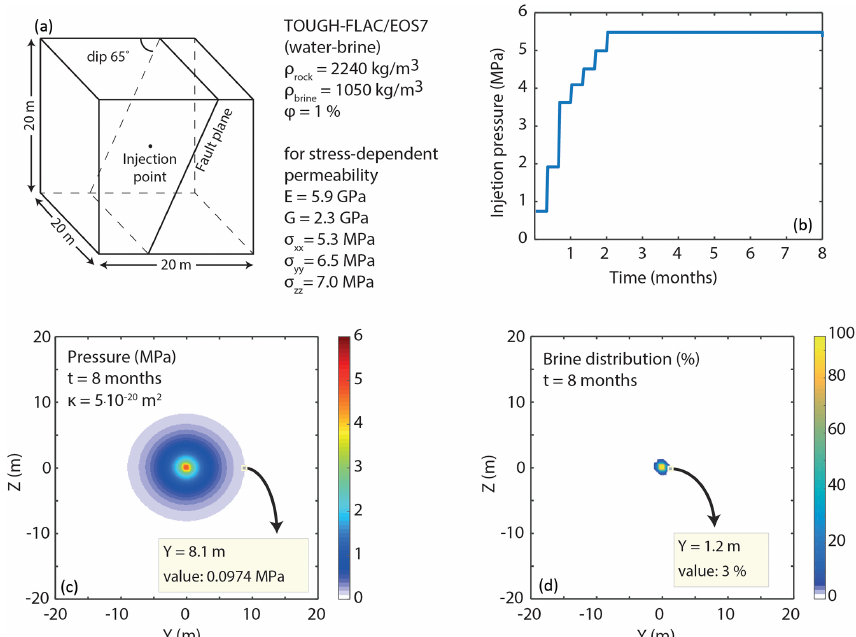
Figure 4. (a) Modeling domain and main properties. (b) The pressure at injection follows a stepwise behavior with monthly increase. (c) Example of a simulated distribution of pressure changes around the injection point after 8 months of constant head injection for a permeability of 5 × 10 − 20 m 2 . (d) Simulated injected brine distribution after 8 months of constant head injection for a permeability of 5 × 10 − 20 m 2